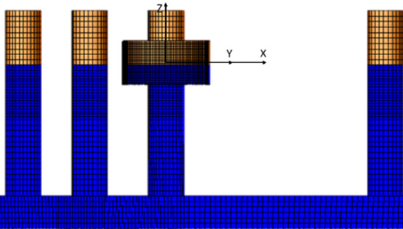
Figure 2. Panel models for the hydrodynamic analysis. Table 2. The main parameters of the combined system.